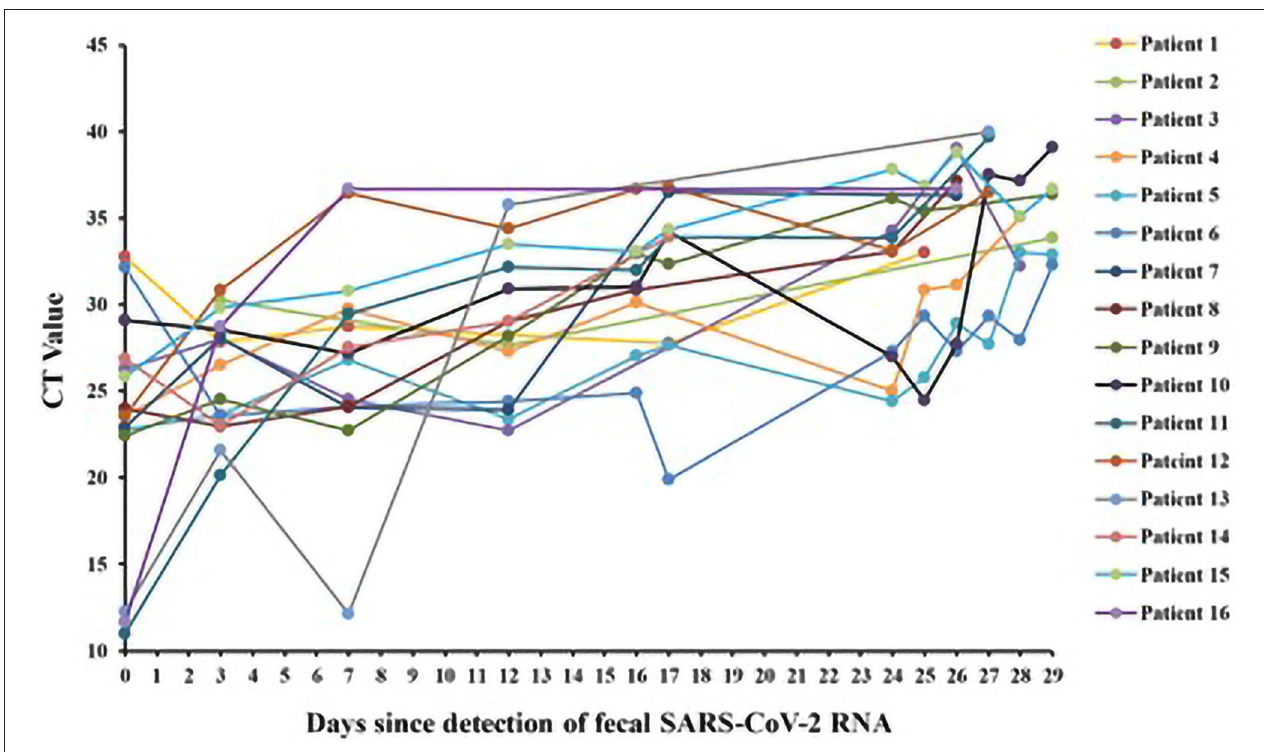
FIGURE 3 | CT values of fecal SARS-CoV-2 RNA in patients with persistently positive SARS-CoV-2 RNA in feces ( n = 16).